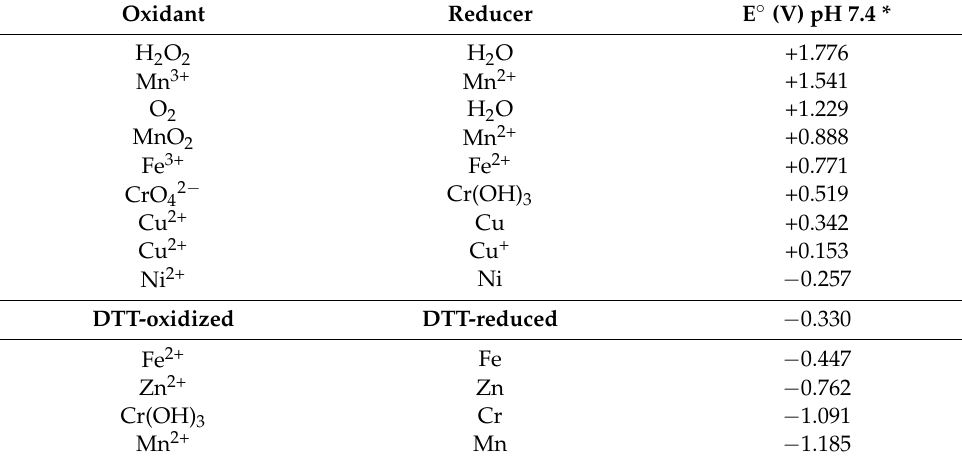
Table A8. List of redox potentials at T = 25 ◦ C, P = 1 atm [112], pH